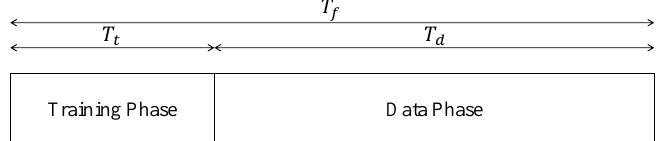
Figure 2. Communication over the frames of duration T f , each with a training phase of duration T t